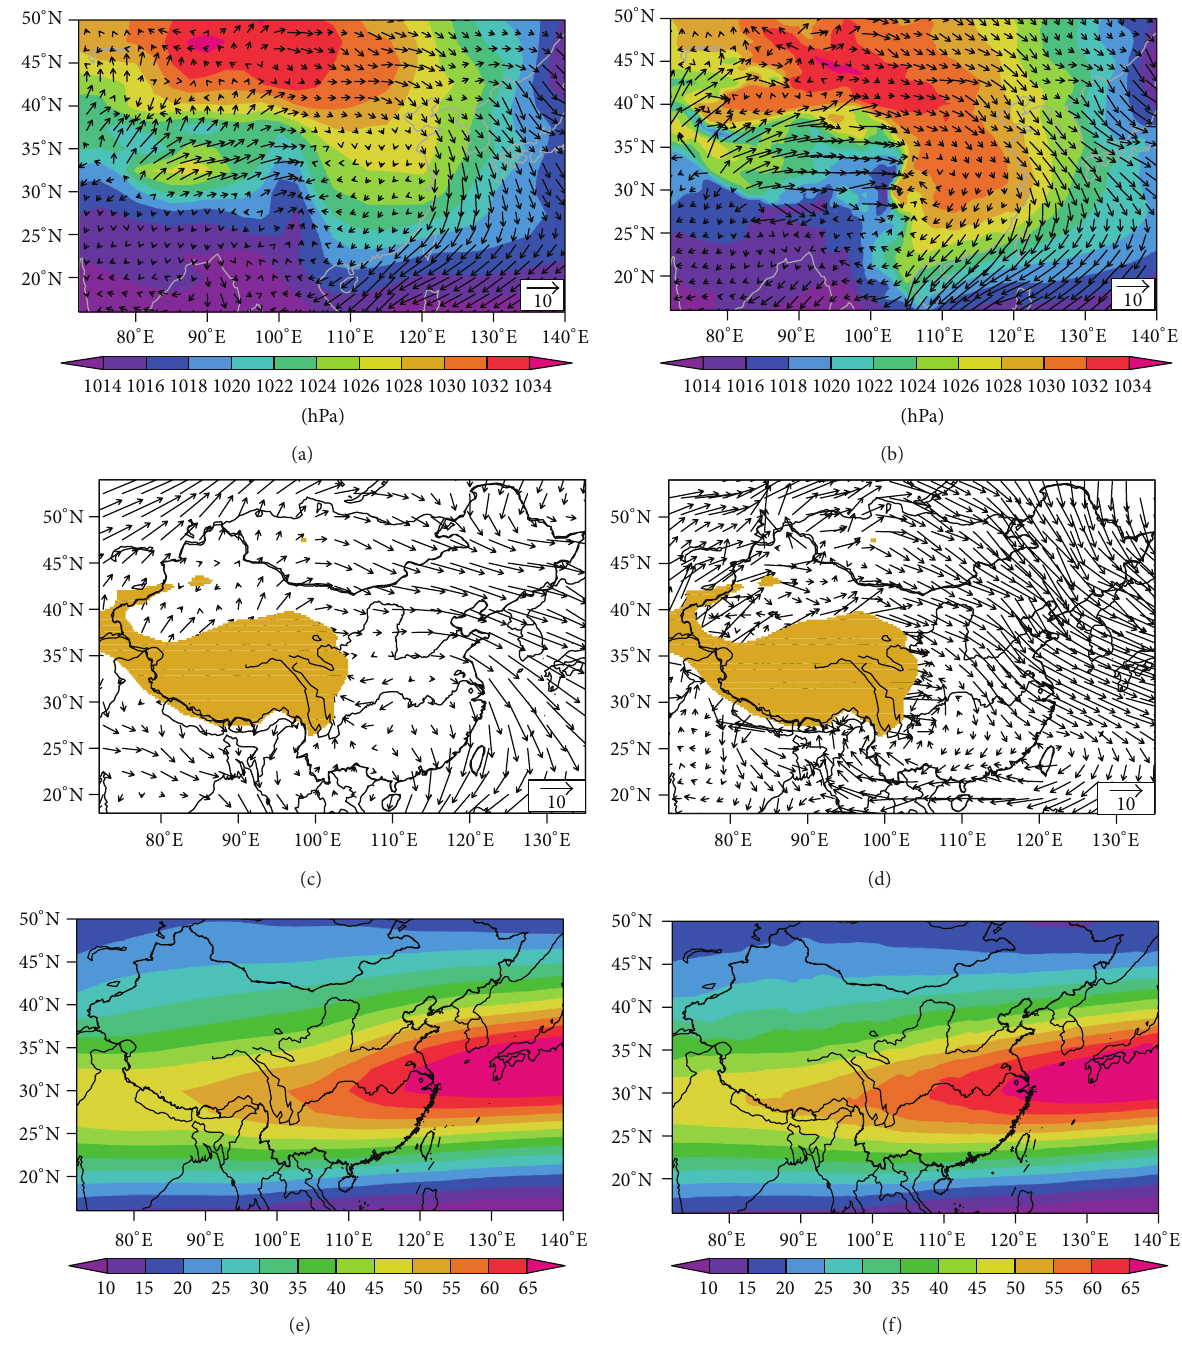
Figure 2: Comparison between the NCEP-DOE reanalysis (a, c, e) and Nodust experiment simulated (b, d, f), the SLP (hPa) superimposed on the surface wind (ms −1 ) (a, b), the 850 hPa wind (c, d), and the 200 hPa U component of wind (e, f), averaged in winter (DJF) during 2000–2009 period. The yellow area in (c, d) represents the topography below 850 hPa altitude.